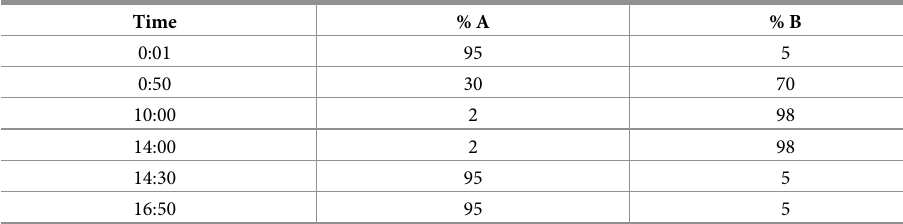
Table 2. Liquid chromatography conditions.